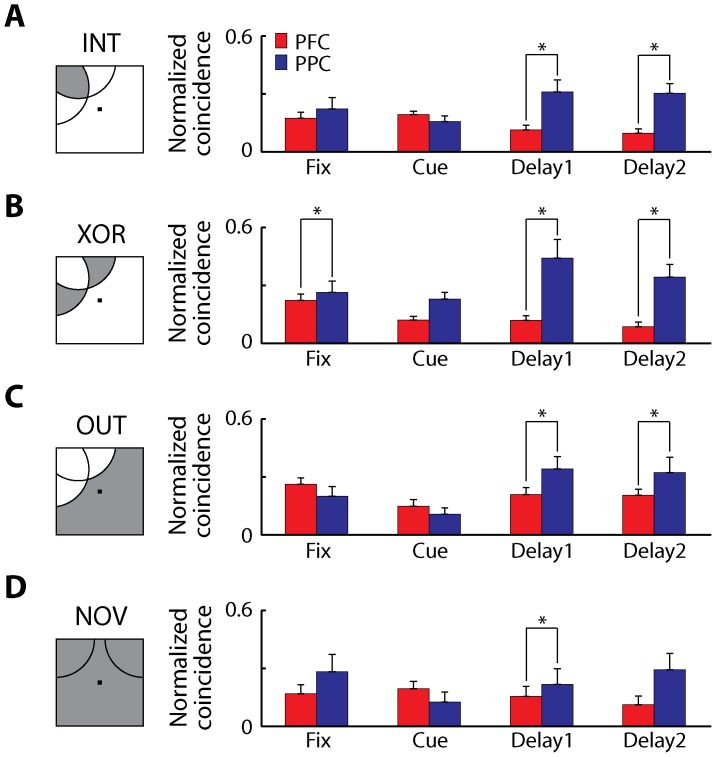
Effective connectivity and receptive field type.Average normalized coincident spikes occurring within the center bin of the PSCCHs are plotted for each receptive field type of pairs of neurons for the dlPFC (red) and the PPC (blue). Neuron pairs with/without significant delay activity were used in this figure. Each task epoch lasted 0.5 s; the delay period was divided into bins each lasting 0.5 s. Arcs in the insets represent the receptive field of each neuron, and gray shaded areas represent the stimulus location used for each analysis. A) Locations at the intersection of two receptive fields (INT, dlPFC: 313 pairs, PPC, 81 pairs). B) Locations at the non-overlapping part of the receptive fields (XOR, dlPFC: 291 pairs, PPC 101 pairs). C) Locations outside of both receptive fields (OUT, dlPFC: 306 pairs, PPC: 101 pairs). D) Pairs with no overlapping receptive-fields (NOV, dlPFC: 73 pairs, PPC: 34 pairs). Star marks represent significant differences between groups observed in post-hoc tests (Tukey's LSD, p<0.05 for all comparison).